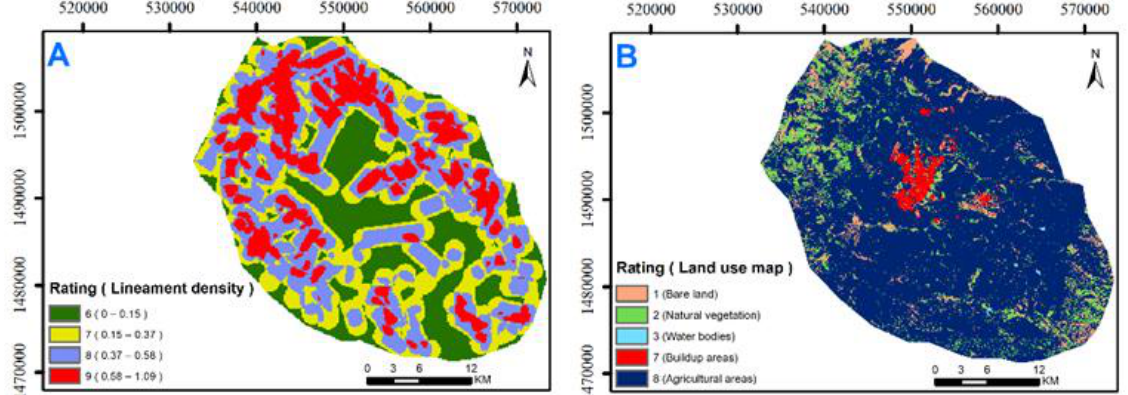
Figure 5. Two additional input thematic layers and their ratings to modify the conventional DRASTIC model: ( A ) lineament density; ( B ) land use map.